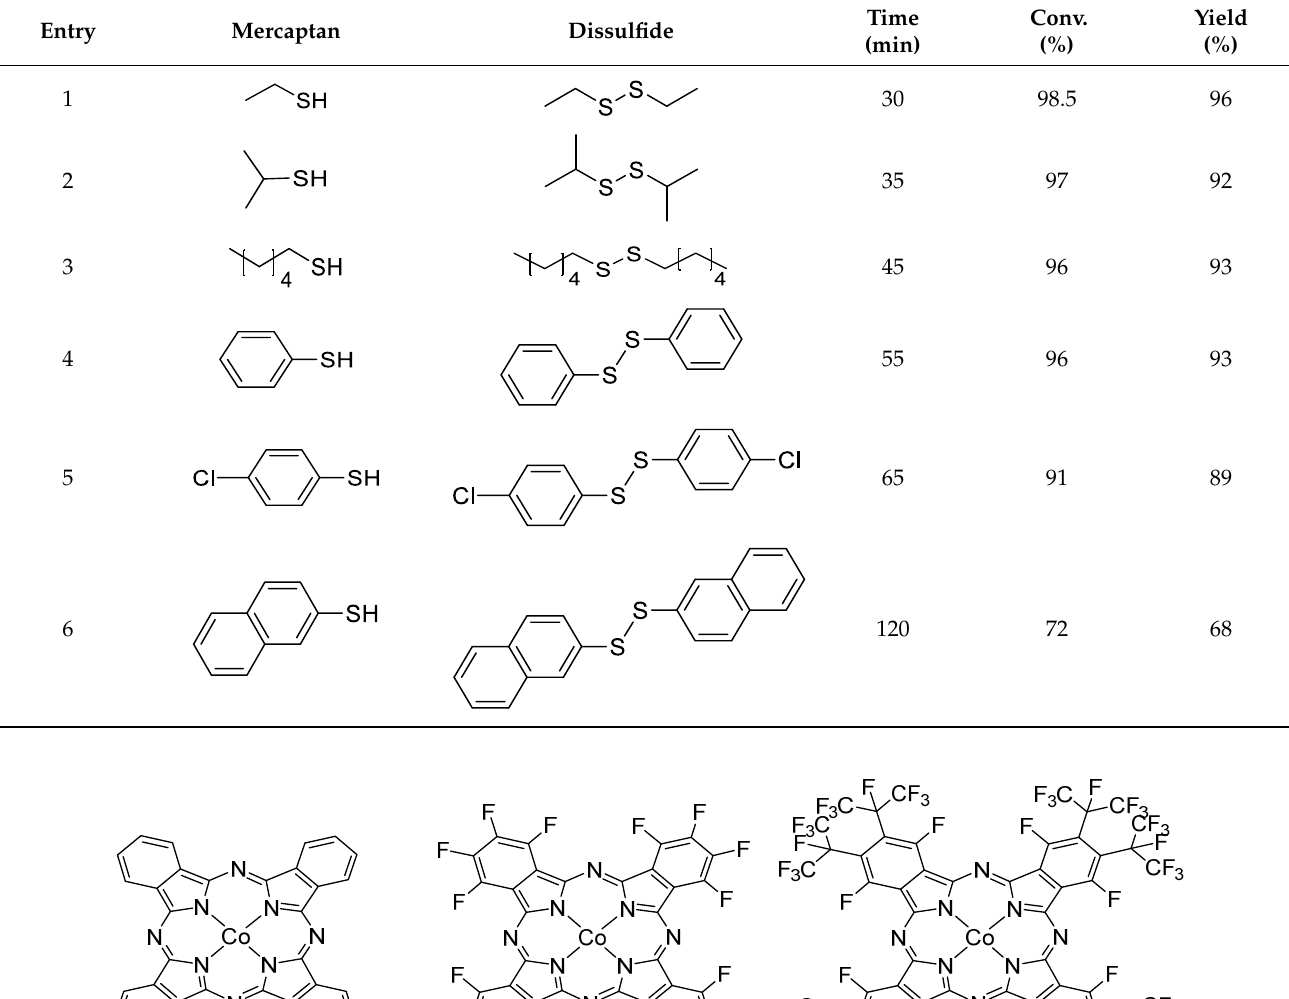
Table 1. Some of the results obtained for mercaptan aerobic oxidation mediated by Co(II)Pc(SO 2 Cl) 3 SO 2 NH@CF as catalyst at room temperature (adapted from [59]) .